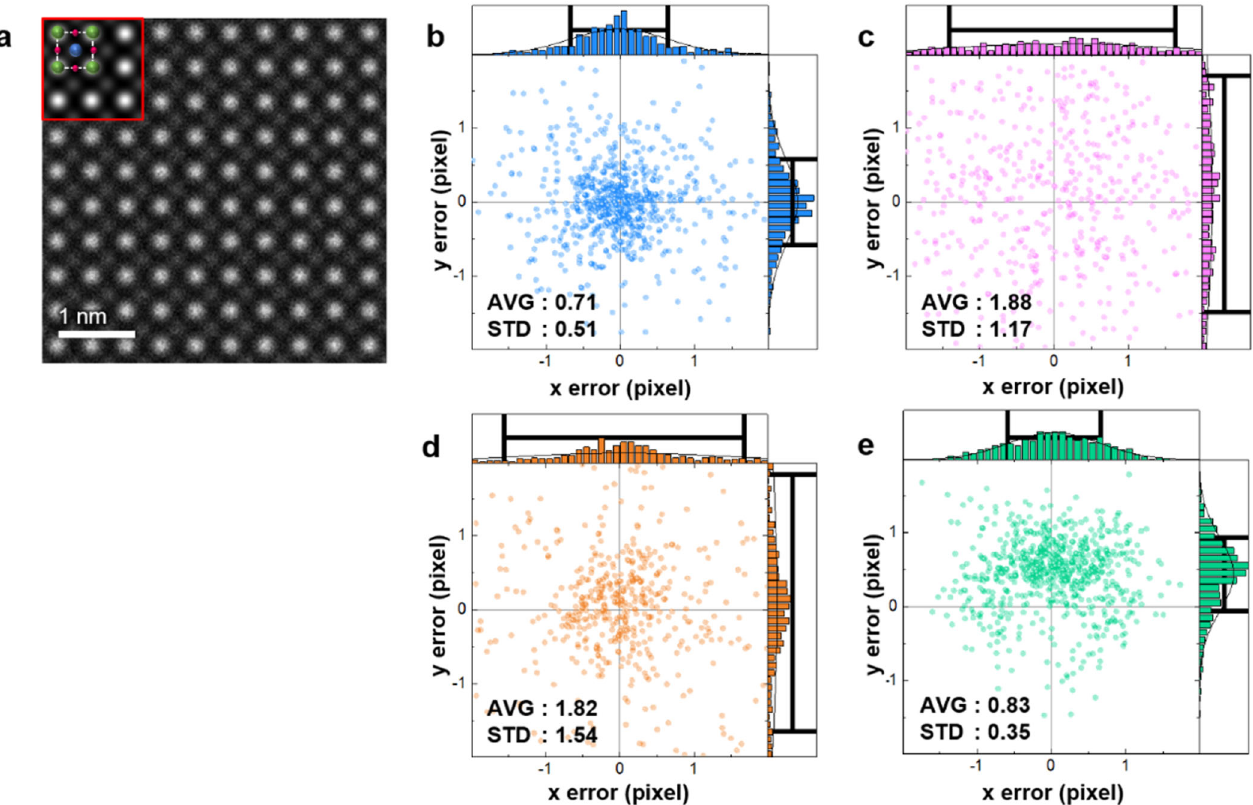
Fig. 5 Comparison of the accuracies on atomic coordinates. a Simulated HAADF – STEM image of SrTiO 3 with arti fi cial Poisson – Gaussian noise along the zone axis of [100]. The green, cyan, and red circles denote Sr, Ti, and O, respectively. The inset shows the noise-free simulation image. b Coordinates error using a combination of the K -means clustering and center of mass method (PRESTem). c 9-point 2D quadratic fi tting (PPA). d Multiple ellipse fi tting (CalAtom). e 2D Gaussian fi tting (Atomap). Each colored dot denotes the deviation from the ground truth. The top and right graphs present the normal distribution of errors in each x- and y- component. The black lines show the one standard deviation of